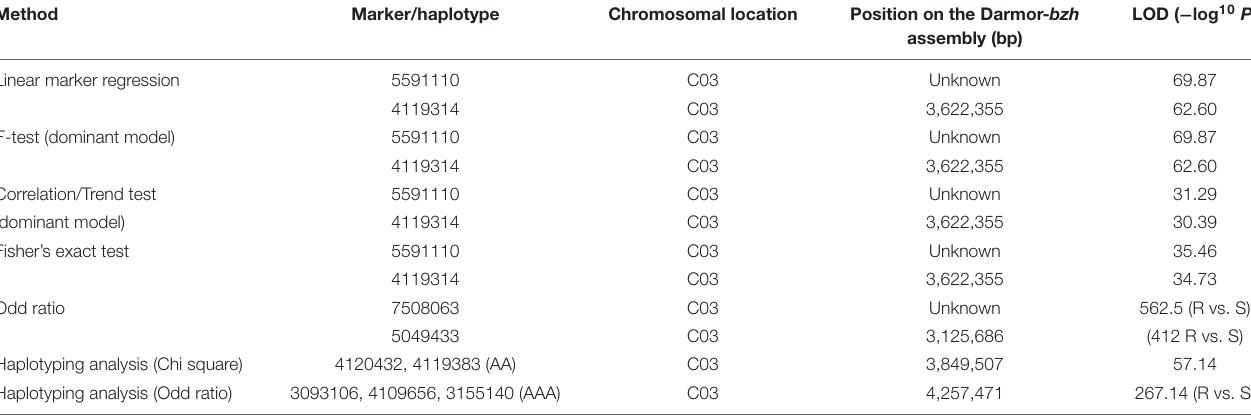
TABLE 2 | Genetic association between GBS-based DArTSeq markers and resistance to L. maculans . Only highly significantly associated markers are shown herein.